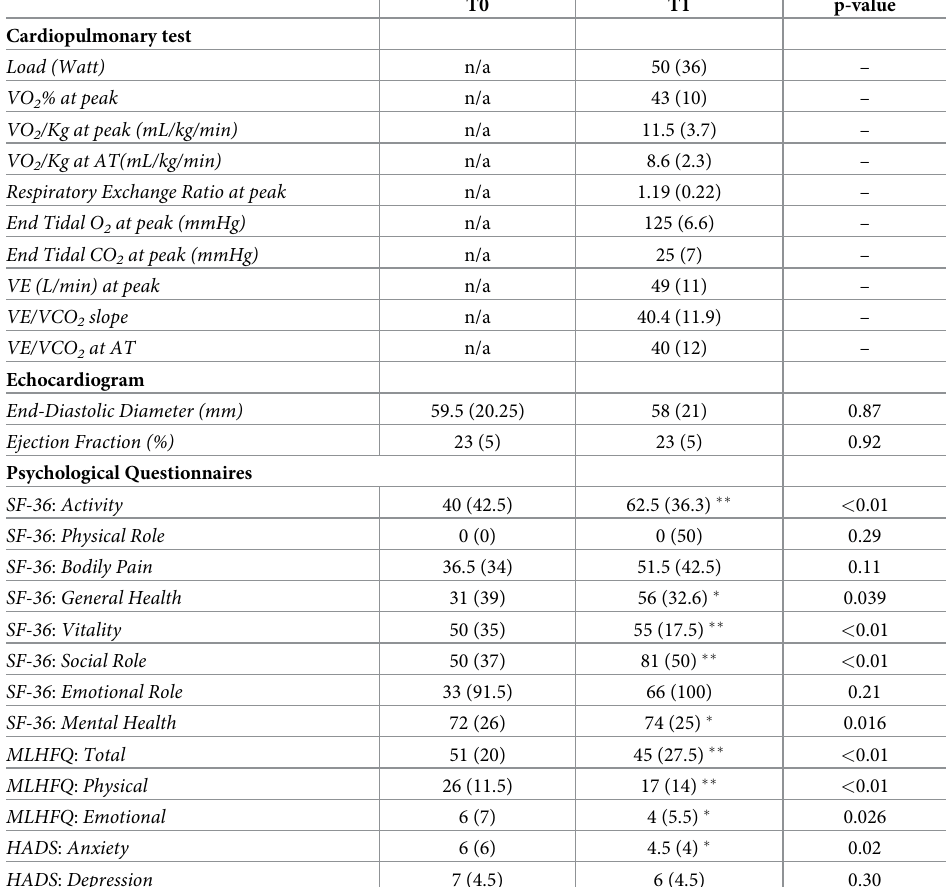
Table 2. LVAD patients: Cardiopulmonary measures and psychological scores at T0 and T1 with significance p of their